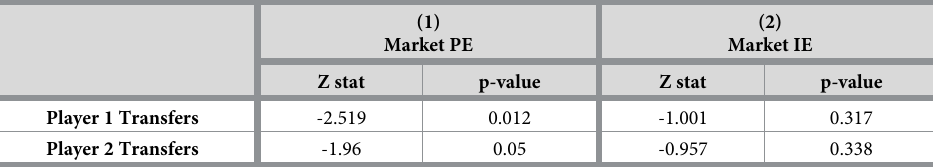
Table 4. Comparison of trust game transfers to negative and positive relationships by treatment.